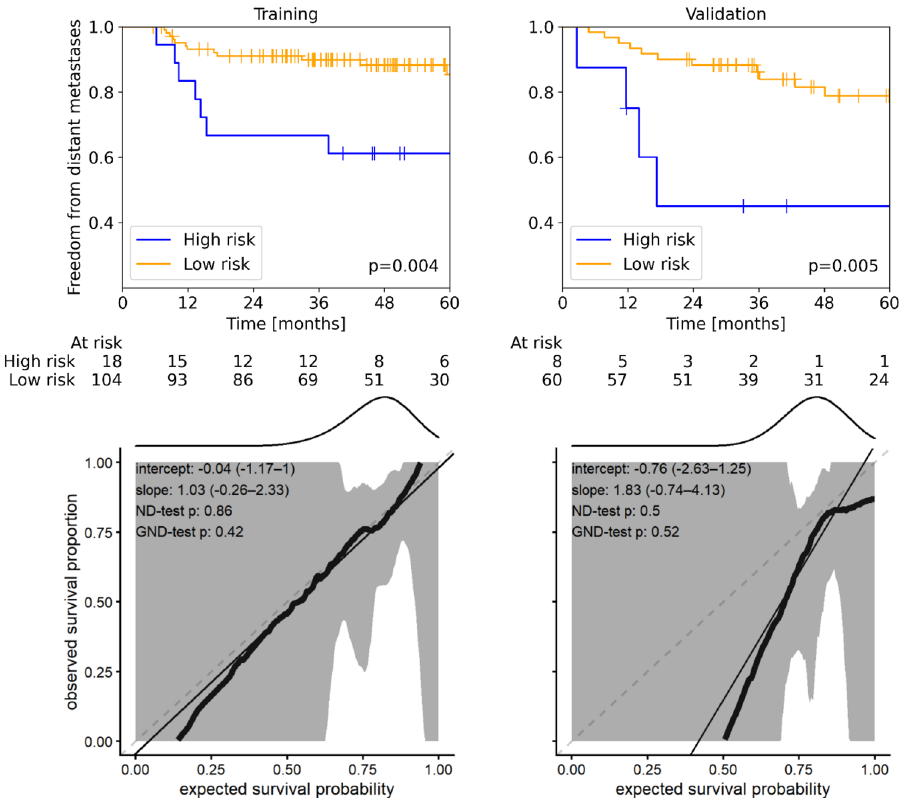
Figure 4. Kaplan–Meier (top) and calibration plots (bottom) on training (left) and validation (right) data for the prediction of FFDM using the three best performing CT-based SOT features, resulting in significant patient stratifications (p < 0.01). For calibration, data (thick lines) and 95% confidence intervals (shaded regions) are shown together with linear regression lines (solid lines) that should follow the optimal expectation (dashed lines). Density of expected probabilities is shown above the calibration plot.